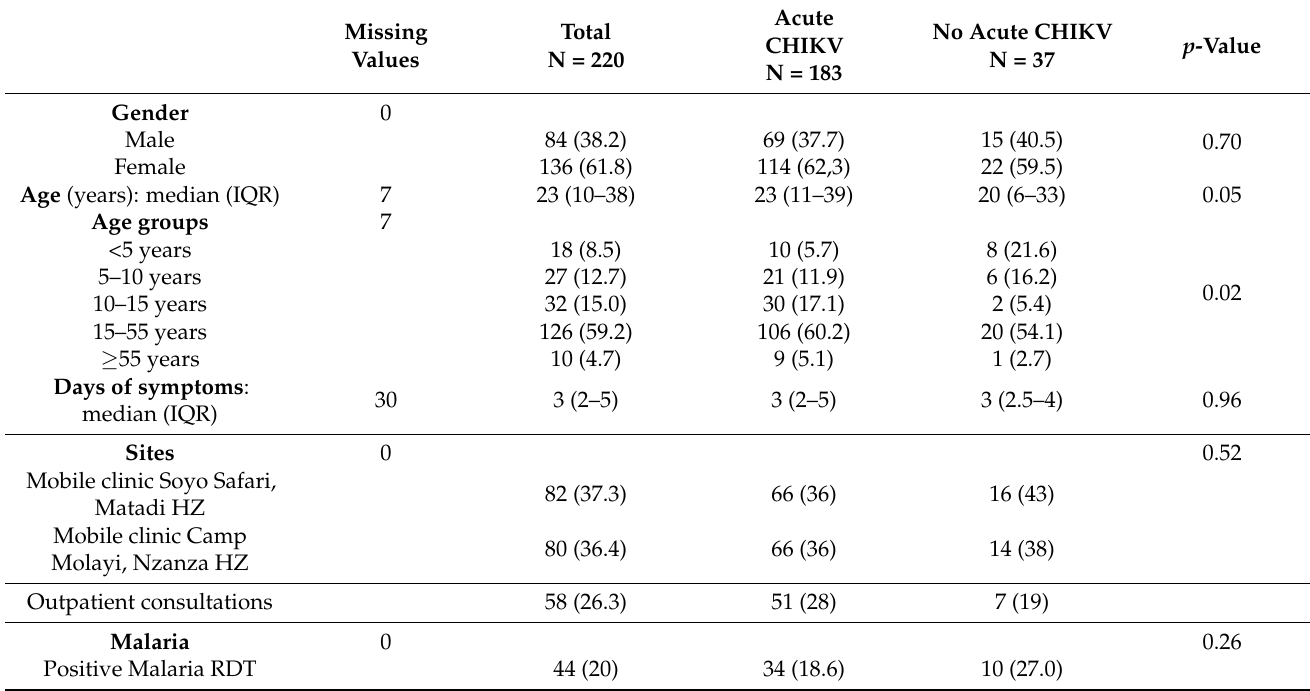
Table 1. Socio-demographic characteristics and malaria results of the clinical suspects seen at the mobile clinics and outpatient department during the investigation, by CHIKV infection status.